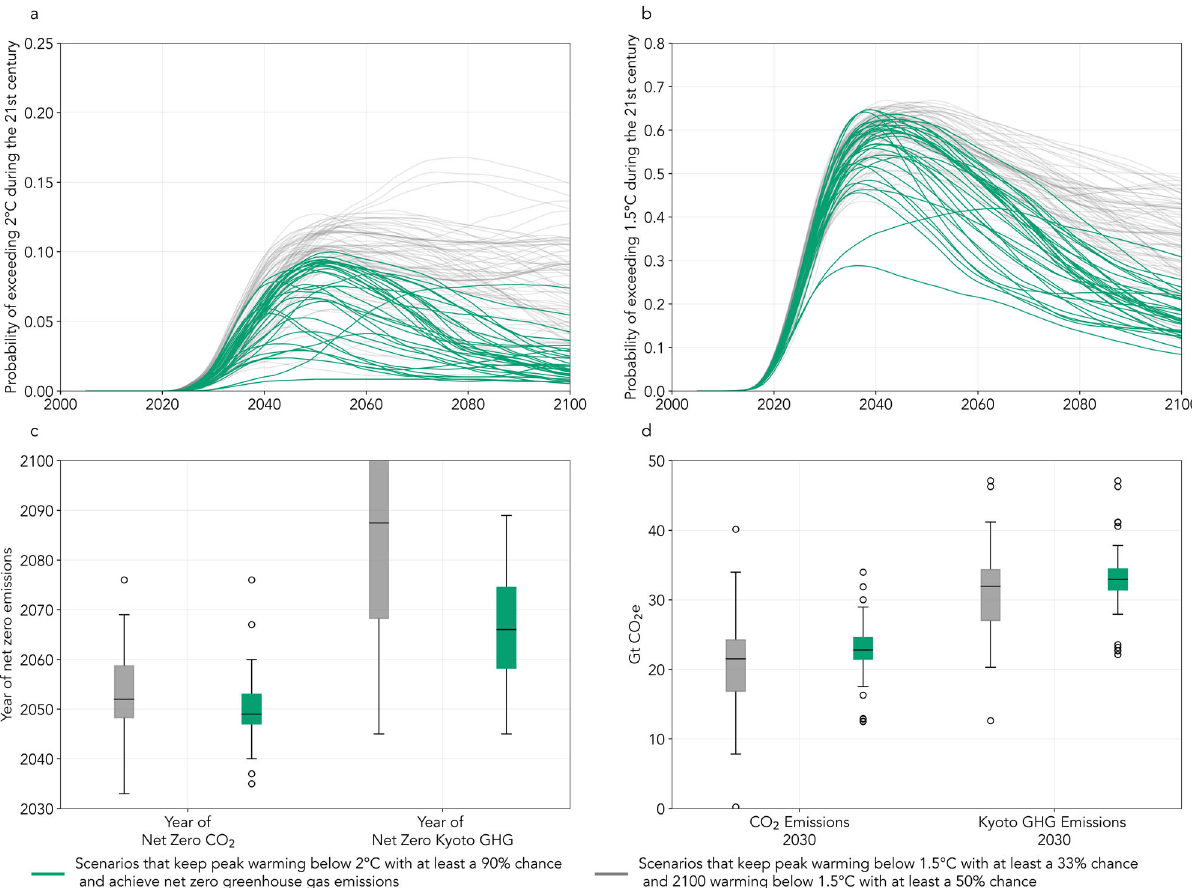
Fig. 3 Characteristics of pathways assessed as Paris Agreement compatible in comparison with the AR6 pathways that limit warming to 1.5 °C (>50%) with no or limited overshoot. a Probability of exceeding 2 °C over the 21st century. b Probability of exceeding 1.5 °C over the 21st century. c Timing of global emissions reaching net zero for CO 2 and Kyoto GHG emissions. d 2030 emission levels for CO 2 and total Kyoto-GHG emissions. The box represents the interquartile range (25th – 75th percentile) and the whiskers represent the range with outlier datapoints (de fi ned as datapoints that lie beyond 1.5 times the interquartile range above the 25 th or 75 th percentiles) represented as individual datapoints. Panel a and b use an 11-year centered running mean (see